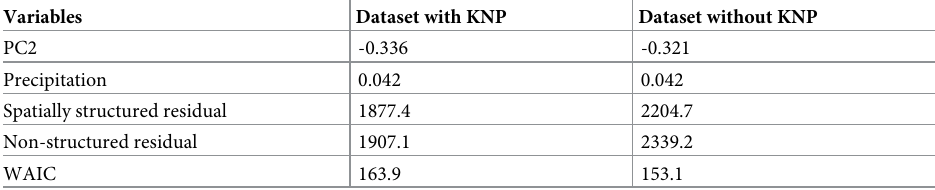
Table 5. Multivariable analysis results for INLA using a zero-inflated convolution models with negative binomial errors for predicting dog rabies cases in South Africa between 1998 and 2002 using datasets with and without Kru- ger National Park.